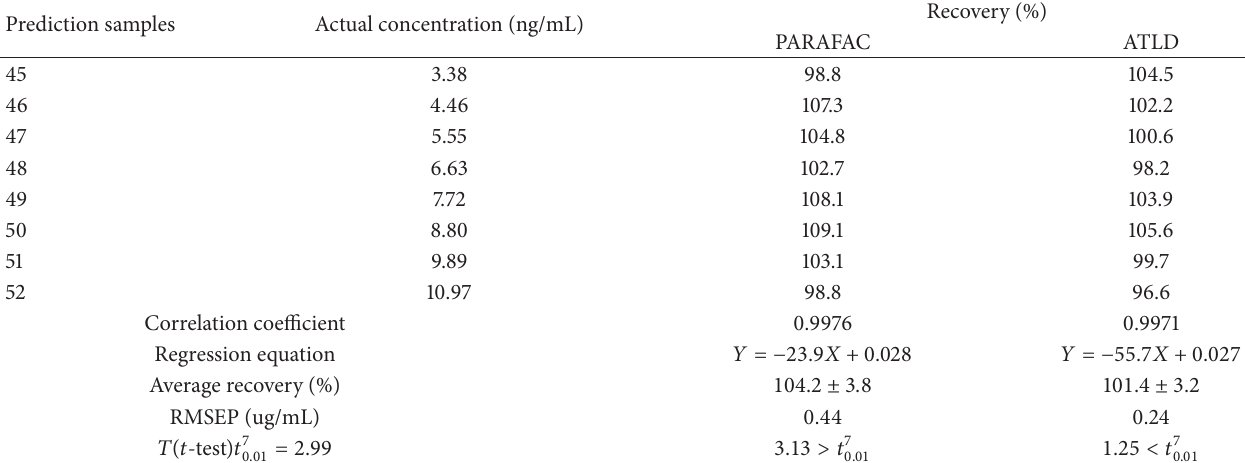
Table 4: Determination of amlodipine besylate in human plasma using PARAFAC and ATLD. Prediction samples